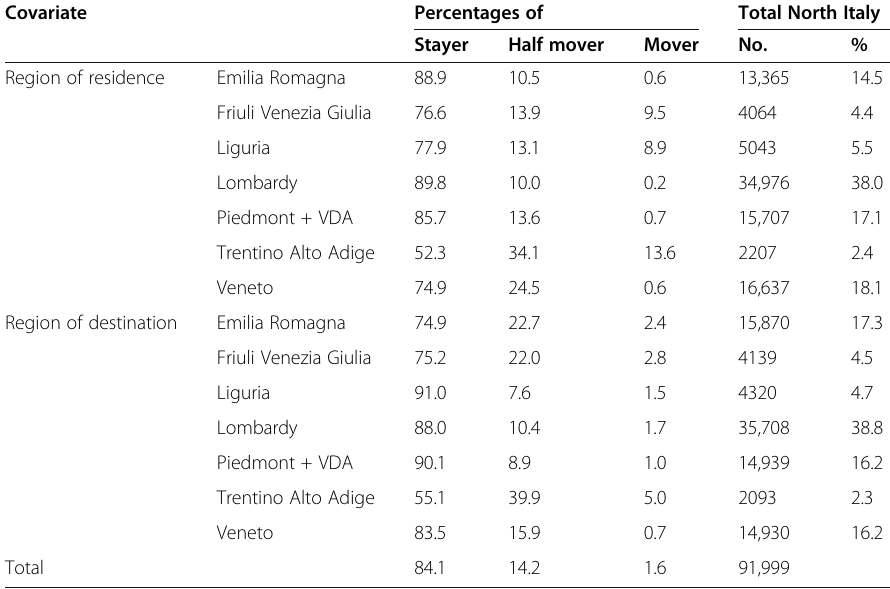
Table 4 Northern first-year students, enroled at an Italian University in 2017, by region of residence and region of destination